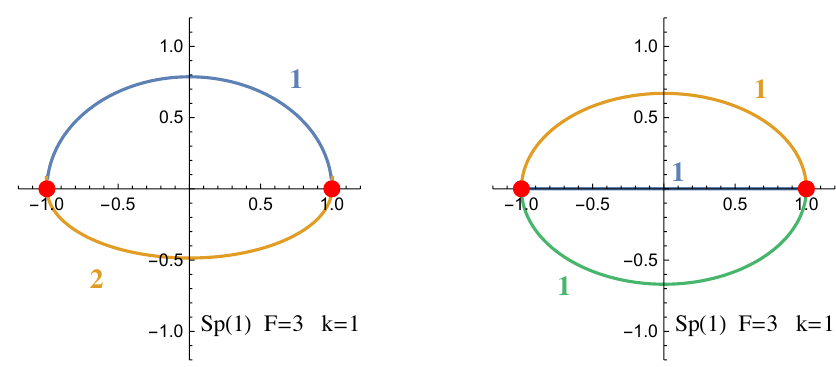
Figure 7 . Examples of deformed domain walls solutions in Sp(1) , F = 3 : on the left the parameters of the deformation (3.18) are (cid:15) = (0 . 005 , 0 . 005 , 0) . On the right the parameters are (cid:15) i